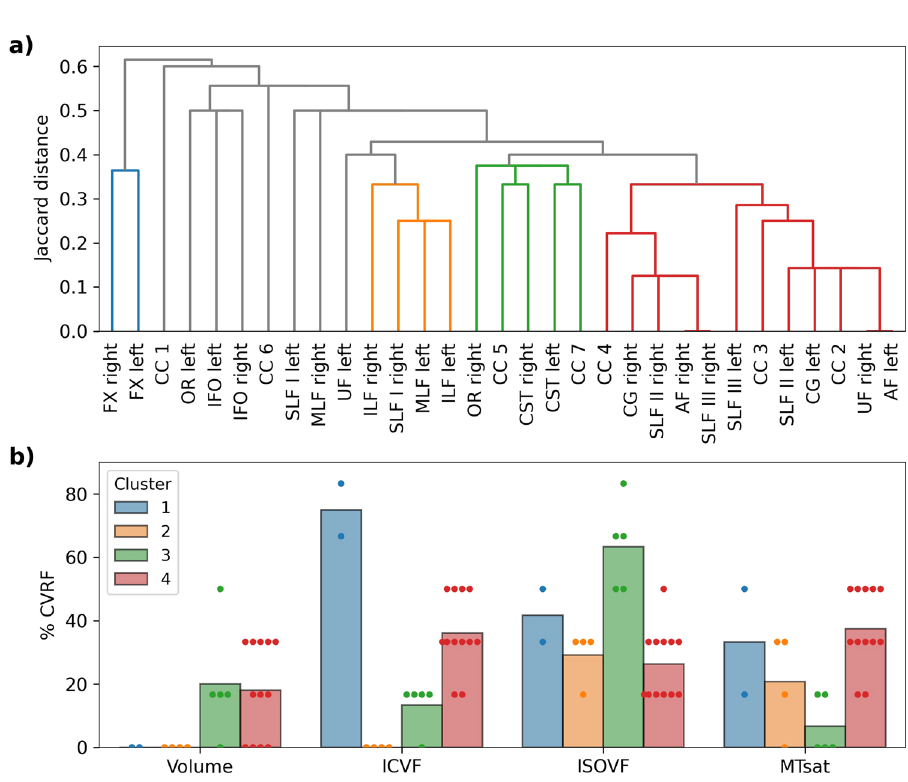
Fig. 3 Clustering of tracts based on their associations with cardiovascular risk factors. a Hierarchical clustering of tracts based on the Jaccard distance between patterns of association with CVRFs (signi fi cant vs. non-signi fi cant). Blue (cluster 1), orange (cluster 2), green (cluster 3) and red (cluster 4) indicate clusters of tracts with inter-tract distance <65% of the maximum distance. Grey indicates all other (i.e., not clustered) tracts. b Mean percentage of CVRFs signi fi cantly associated with each of the four clusters shown in a , for volume, ICVF, ISOVF and MTsat separately. Each dot represents a tract. AF arcuate fasciculus, CC corpus callosum (1 = rostrum, 2 = genu, 3 = rostral body, 4 = anterior midbody, 5 = posterior midbody, 6 = isthmus, 7 = splenium), CG cingulum bundle, CST cortico-spinal tract, FX fornix, ICVF intra-cellular volume fraction, IFO inferior fronto-occipital fasciculus, ILF inferior longitudinal fasciculus, ISOVF isotropic volume fraction, MLF middle longitudinal fasciculus, MTsat magnetization transfer saturation, OR optic radiation, SLF superior longitudinal fasciculus, UF uncinate